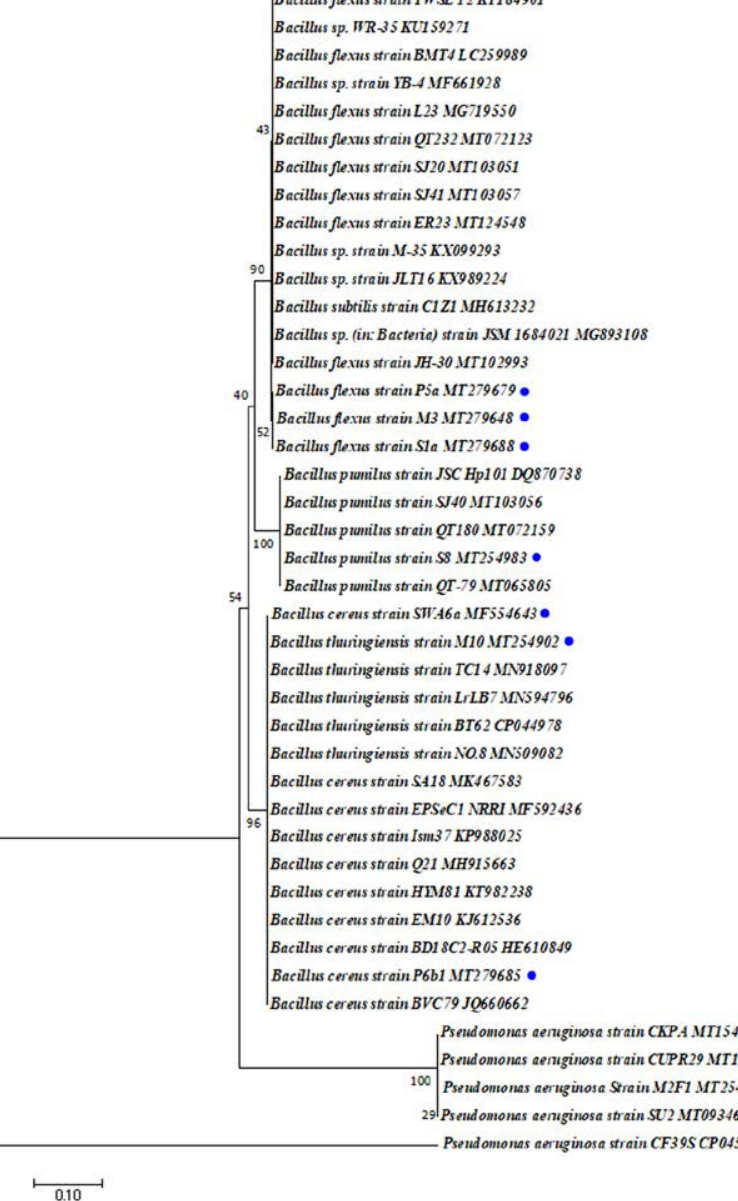
Fig. 3. Tree showing the phylogenetic relationship amongst the probiotic strains. A total of 45 nucleotide sequences were used involving 709 positions in the final